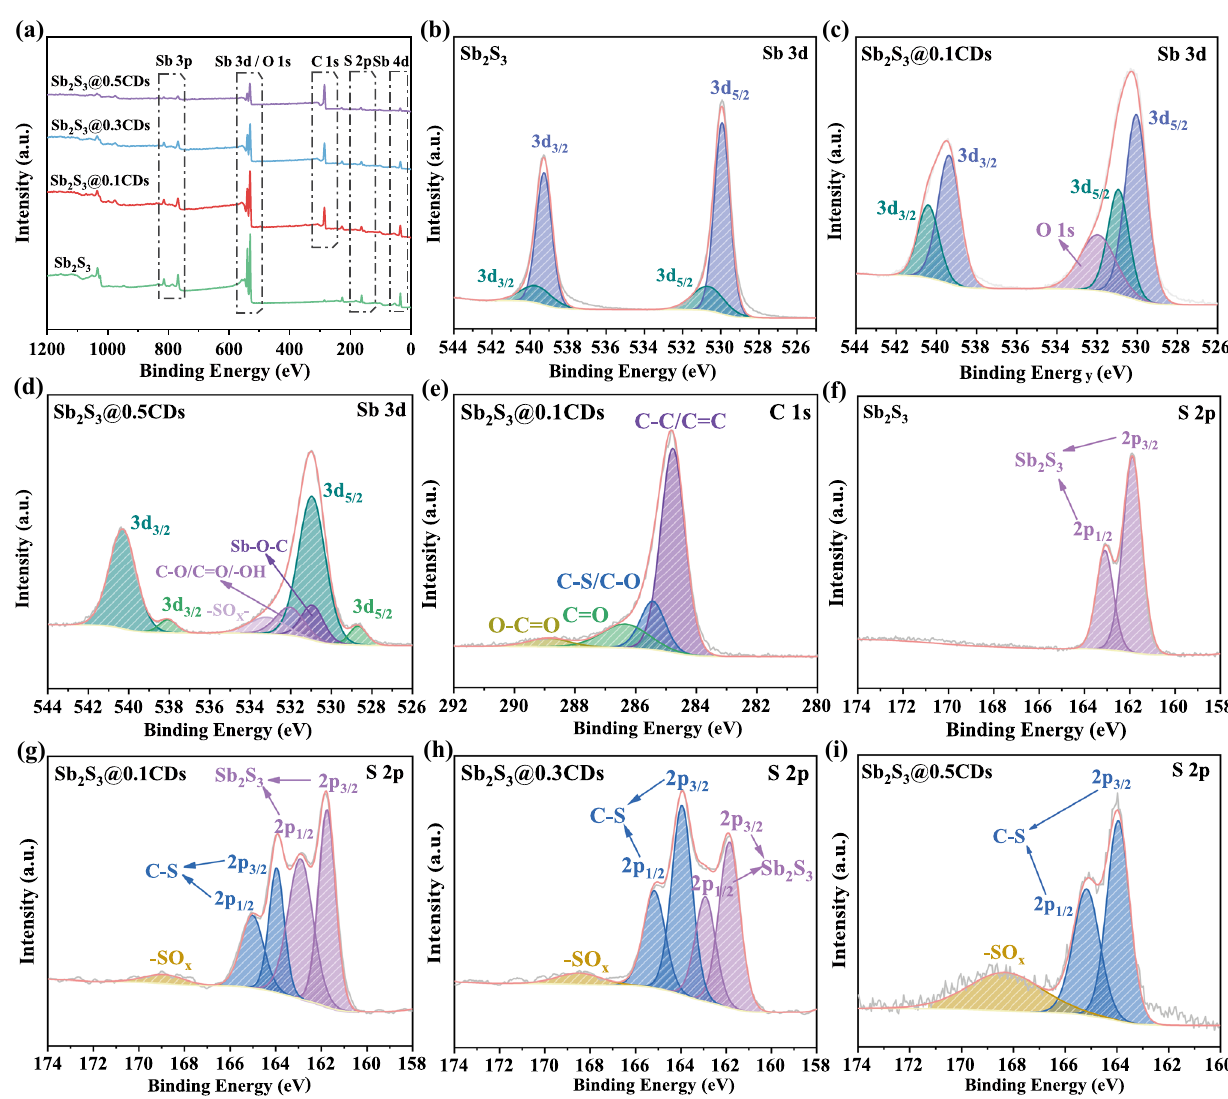
Fig. 4 a Full XPS survey spectra. High-resolution XPS spectra of Sb 3 d and S 2 p of ( b, f ) stibnite Sb 2 S 3 , c, e, g Sb 3 d , C 1 s , and S 2 p spectra of